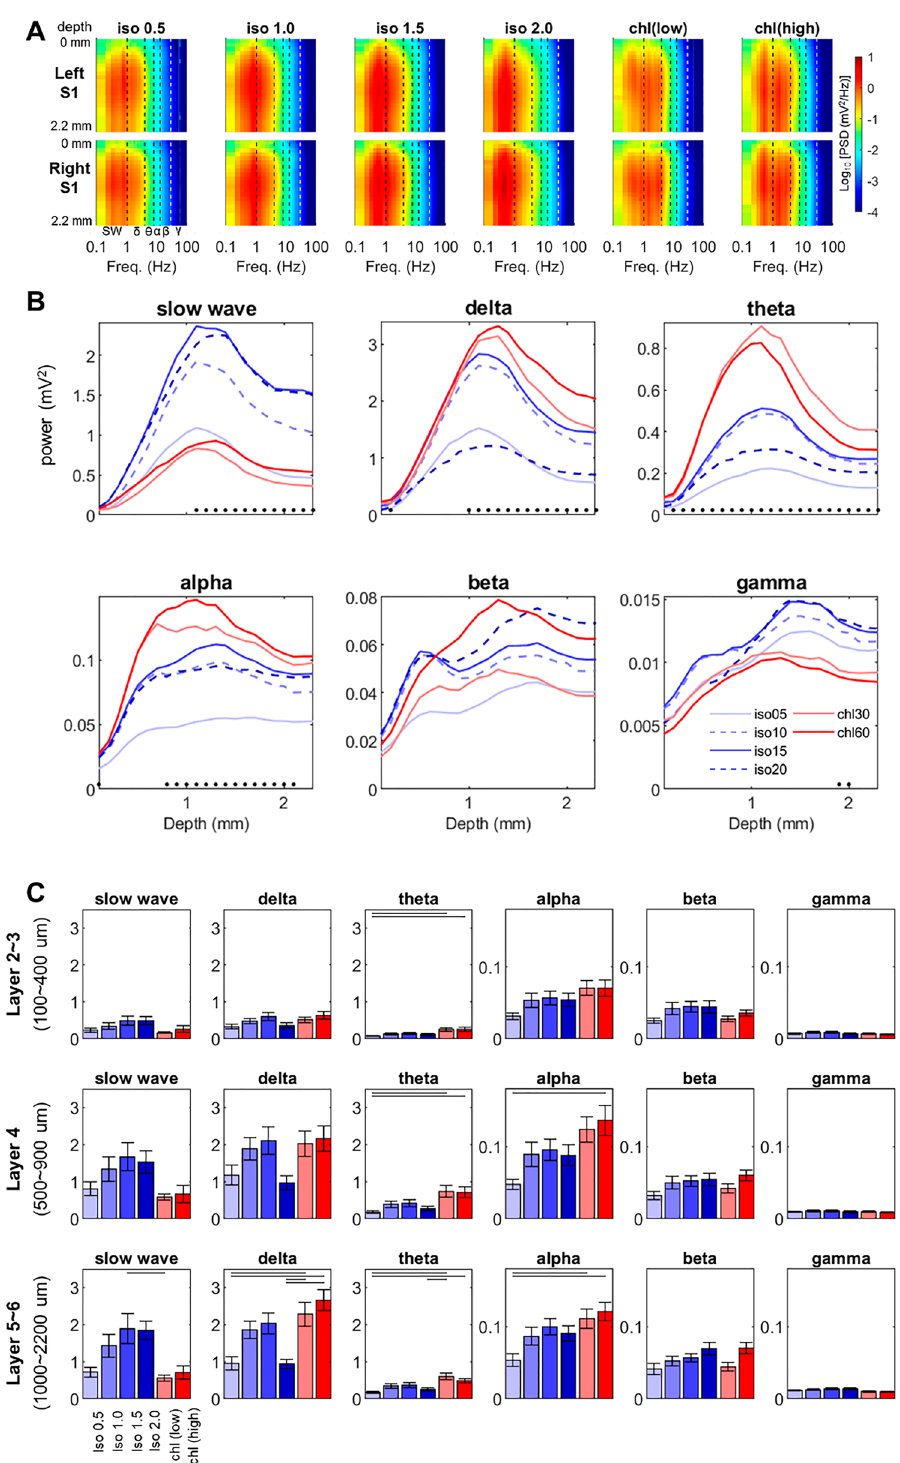
Figure 2. Spectral power of spontaneous LFP activity across different anesthesia conditions. ( A ) Power spectral density (PSD, in mV 2 /Hz) along the cortical depth. ( B ) Comparison of band power distribution along the cortical depth. Left and right S1fl data were combined in this plot. Black dots indicate significant difference across anesthesia conditions (p < 0.05, Friedman test). ( C ) Post-hoc comparisons on the average band power in the supragranular (layer 2 ~ 3), the granular (layer 4) and the infragranular layer (layer 5 ~ 6) (p < 0.05, Tukey’s test). Note that y-axis scale is 0 ~ 3.5 mV 2 for slow wave, delta and theta bands, and 0 ~ 0.18 mV 2 for alpha, beta and gamma bands. Slow wave: 0.1 ~ 1 Hz, Delta: 1 ~ 4 Hz, Theta: 4 ~ 8 Hz, Alpha: 8 ~ 13 Hz, Beta: 13 ~ 30 Hz, Gamma: 30 ~ 100 Hz. Horizontal bar: p < 0.05 in post-hoc Tukey’s test. (n = 16; 8 rats × 2